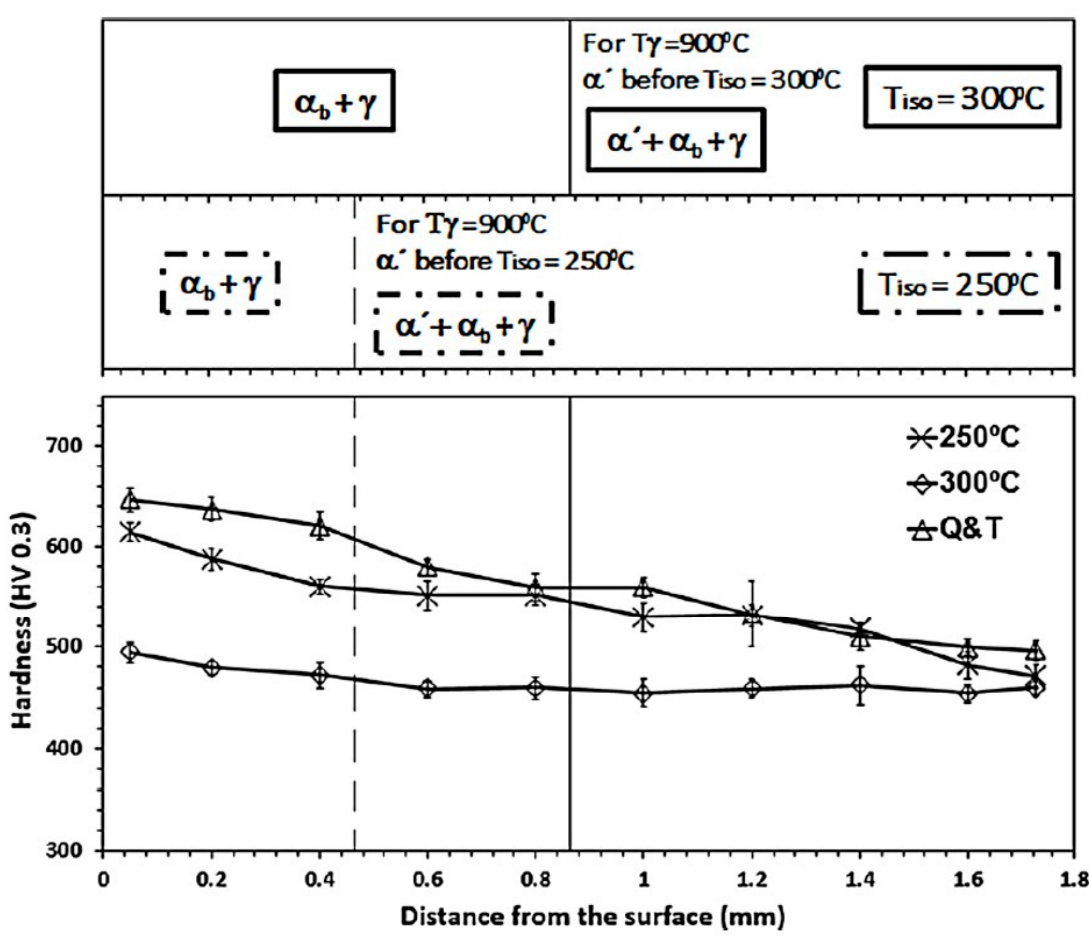
Figure 10. For T γ = 900 ◦ C. Hardness profiles of surface-carburized steels after conventional heat treatment (Q&T) and after isothermal heat